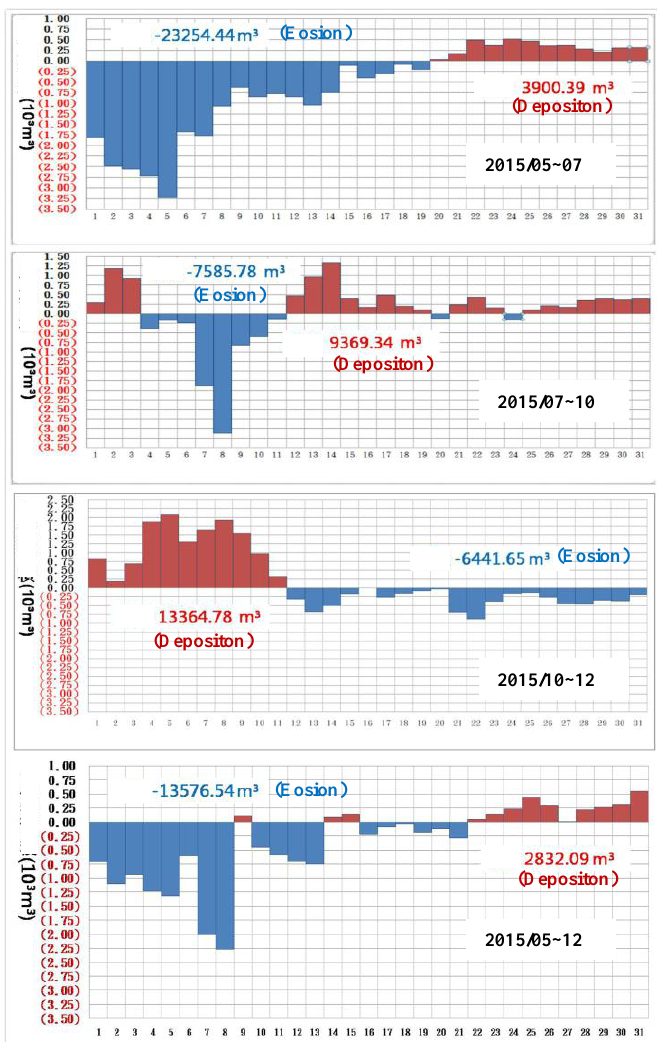
Figure 8 . The volumetric variations of beach budgets